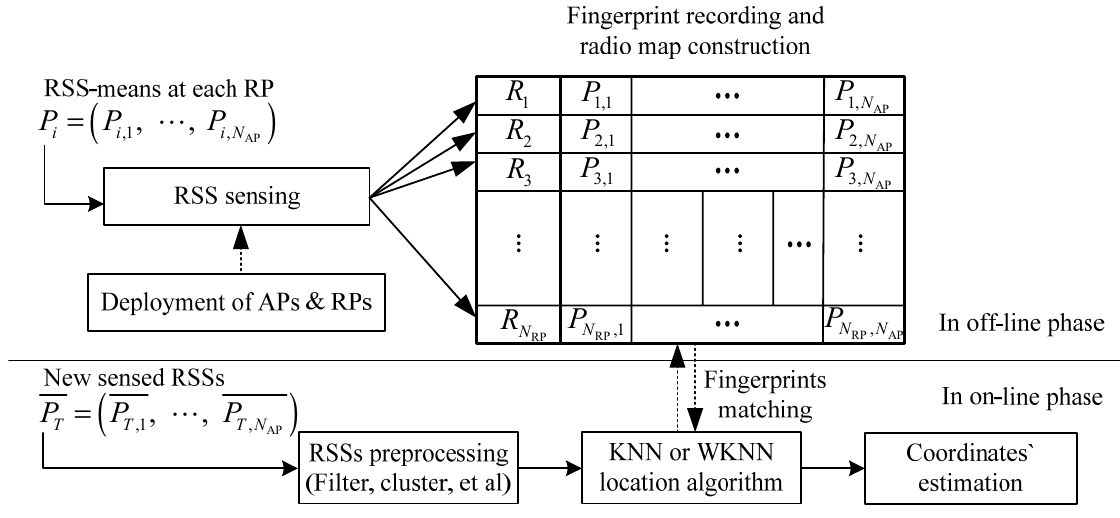
Figure 1. Fingerprint-based RADAR localization system in Wi-Fi